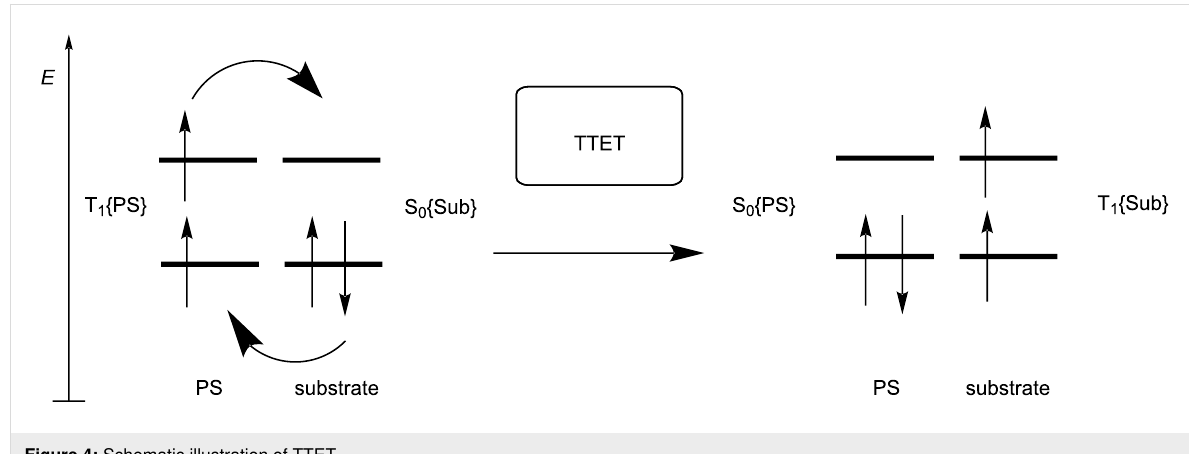
Figure 4: Schematic illustration of